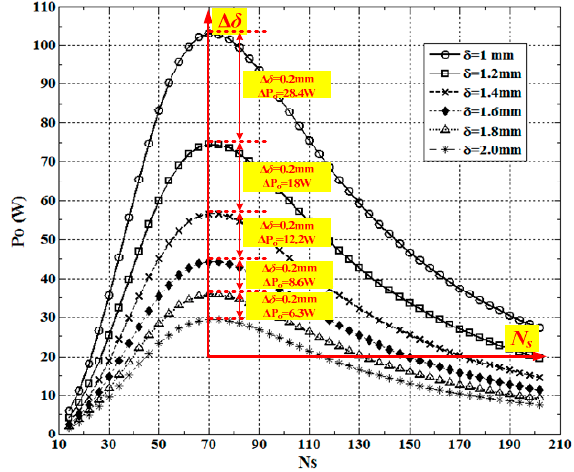
Figure 7. The harvested energy varies with the air gap and the turns of secondary windings.